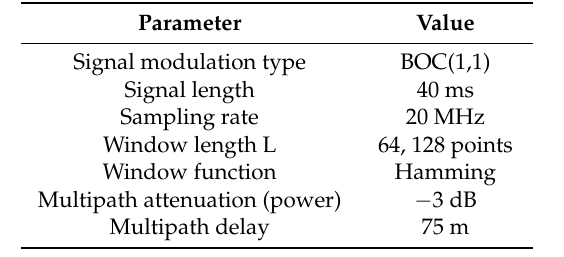
Table 3. Setting of Simulation Parameters.